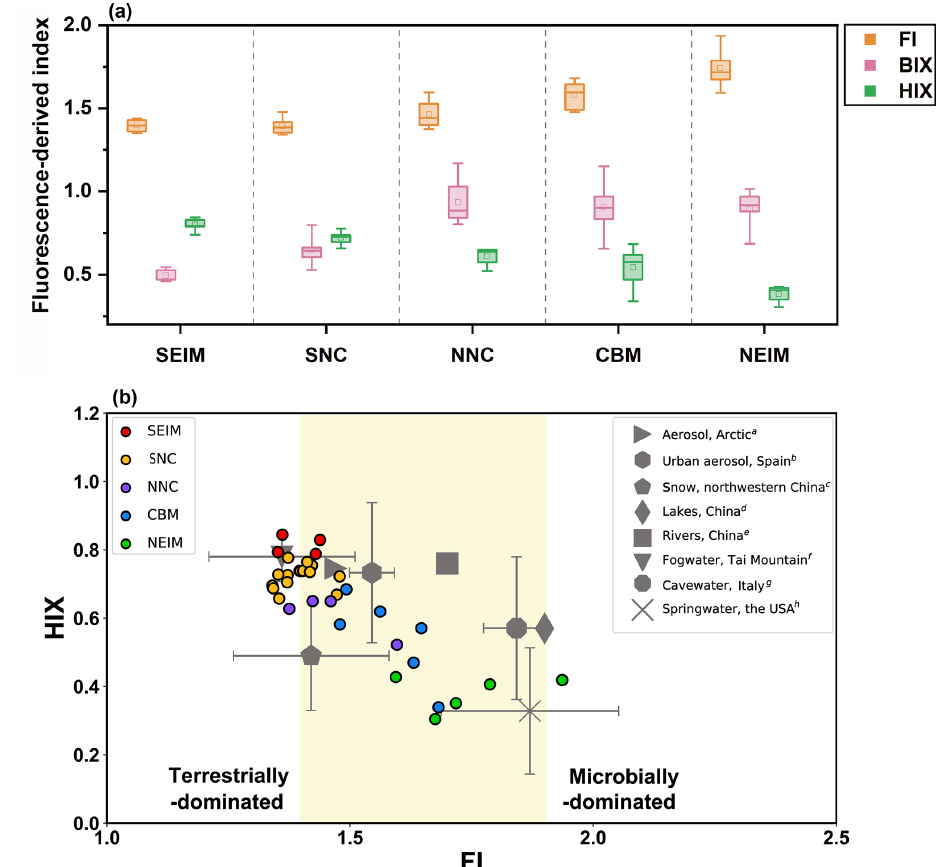
Figure 4. (a) Variations in fluorescence-derived indices among the five groups. Boxes denote the 25 and 75 quantiles, and horizontal lines represent median values. Averages are shown as small boxes, and the whiskers denote maximum and minimum data. (b) Comparison plots of HIX versus FI for the seasonal snow surface samples (colored dots) from northeastern China, together with the average and standard deviation of different types of WSOC (gray markers) adapted from Arctic aerosols ( a Fu et al., 2015), Spanish urban aerosols ( b Mladenov et al., 2011), seasonal snowpack in northwestern China ( c Zhou et al., 2019b), Chinese lakes and rivers ( d , e Zhou et al., 2017), fog water from Tai Mountain, China ( f Birdwell and Valsaraj, 2010), cave water from Frasassi Caves, Italy ( g Birdwell and Engel, 2010), and spring water in the USA ( h Birdwell and Engel, 2010). Shaded areas represent mixed WSOC